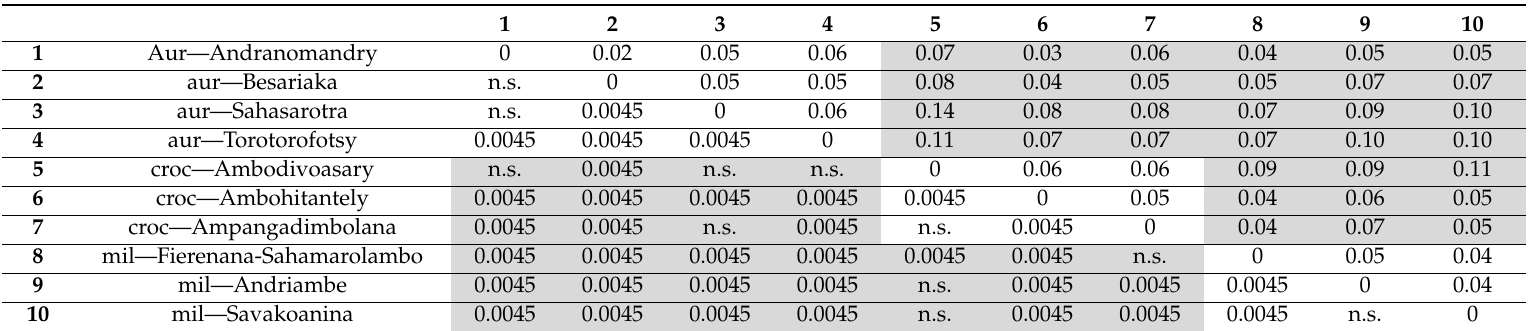
Table 2. Pairwise F ST between sampling localities. Fields in white correspond to within species comparisons, and fields in grey to between species comparisons. F ST values can be found above the diagonal, Bonferroni corrected p -values are provided below the diagonal with non-significant p -values (i.e., p -values > 0.05) indicated as n.s. aur— M. aurantiaca ; croc— M. crocea ; mil— M. milotympanum